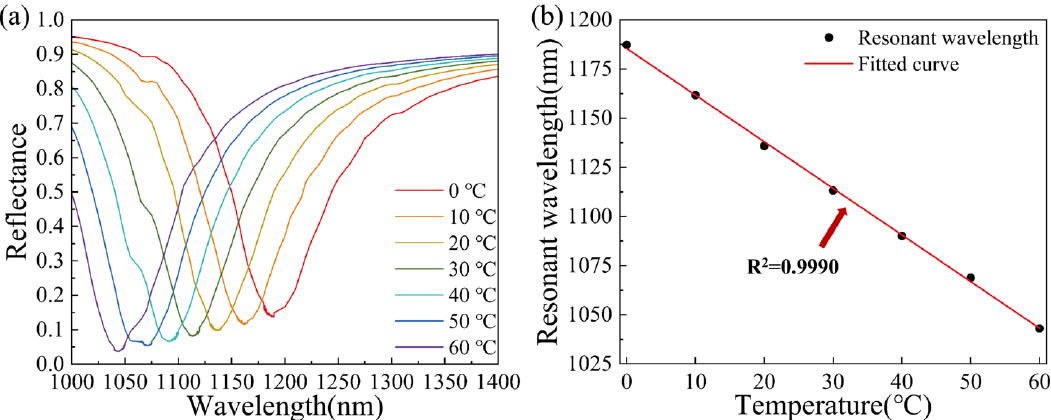
Figure 8. ( a ) The reflectance curve of the optimized TiO 2 (film)-Au-TiO 2 (nanorods) triple SPR sensor. ( b ) SPR wavelength corresponding to temperature of the optimized TiO 2 (film)-Au-TiO 2 (nanorods) triple SPR sensor and linear fitting.